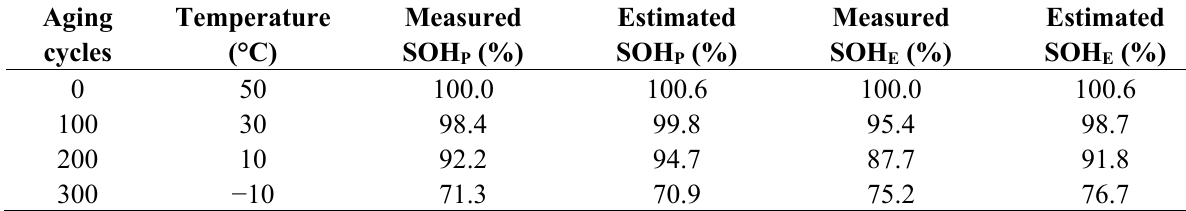
Table 3. Validation results for state-of-health (SOH P and SOH E